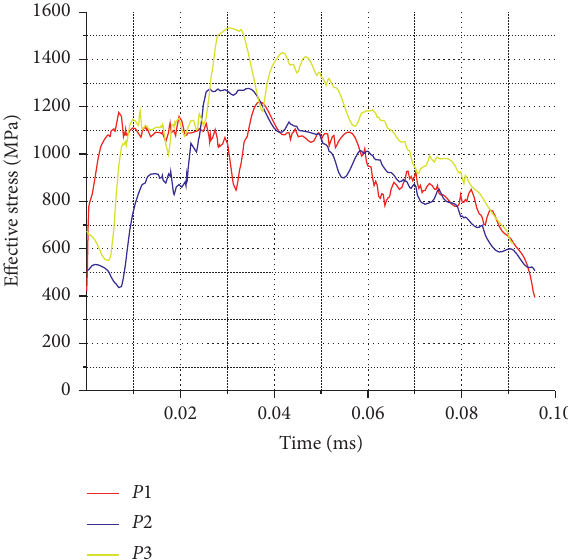
Figure 20: Comparison of the displacement-time history curves of the 35th coil.